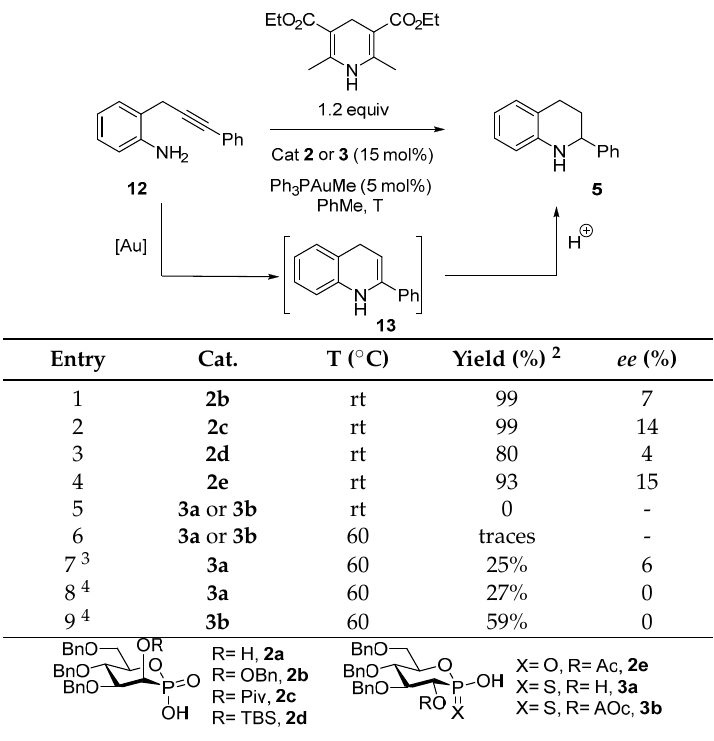
Table 3. Catalytic activity of phosphonate-Au(I) complexes 1 .